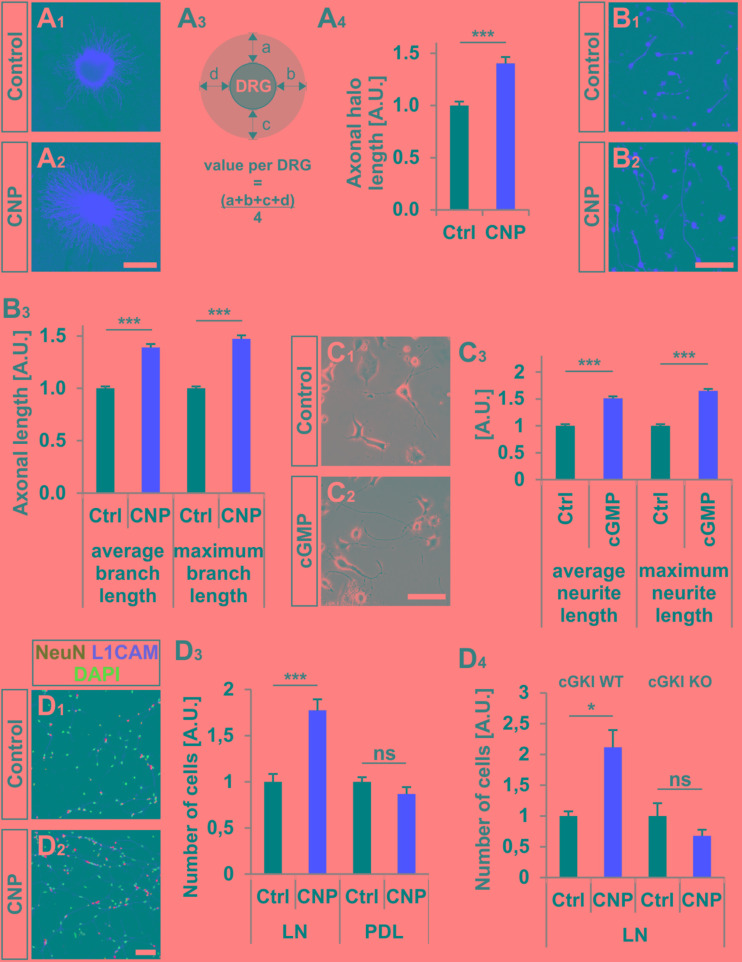
CNP increased neurite length and attachment of DRG neurons to extracellular matrices in culture. (A1–A4) Explants of E7 chick DRGs were grown in collagen matrix in the presence of 500 nM or absence of CNP for 16–20 h and stained with anti-NCAM1 for visualization. Scale bar, 500 μm. (A3) Scheme illustrating the calculation of the axonal halo from DRG explants (light gray). (A4) Quantification of the axonal halo from explants in the presence or absence of CNP. Control n = 12 explants; CNP n = 12 explants; three independent experiments; p < 0.0001 (∗∗∗), unpaired two-tailed t-test. (B1–B3) E7 chick DRG single cells cultured in a collagen matrix in the presence or absence of CNP for 16–20 h. Scale bar, 100 μm. (B3) Quantification of neurite length. Control n = 1671 cells; CNP n = 1077. (C1–C3) The length of neurites of F11 cells grown on PDL/laminin1 are increased by a cGMP analog (1 mM 8-pCPT-cGMP) treatment overnight. The average and the maximum lengths increased by 51 ± 4%, (mean ± SEM) and 65 ± 4% on PDL/laminin1, respectively. Three independent experiments n = 923 (control) and 1000 (8-pCPT-cGMP) cells measured p < 0.0001 (∗∗∗), unpaired two-tailed t-test. Scale bar, 100 μm. (D1–D4) Attached E13.5 mouse embryonic DRG cells on laminin1 or PDL after 16–20 h. (D1,D2) DRG cells were stained with anti NeuN, anti-L1CAM and DAPI and manually counted. (D3) Quantification of attached cells on laminin1 or PDL treated and untreated with CNP. (D4) Quantification of wild type or cGKI-deficient DRG neurons attaching to laminin1 in the presence or absence of CNP. Five independent experiments for wild type and 3 for knockout; p < 0.05 (∗). Scale bar in (D2), 100 μm.